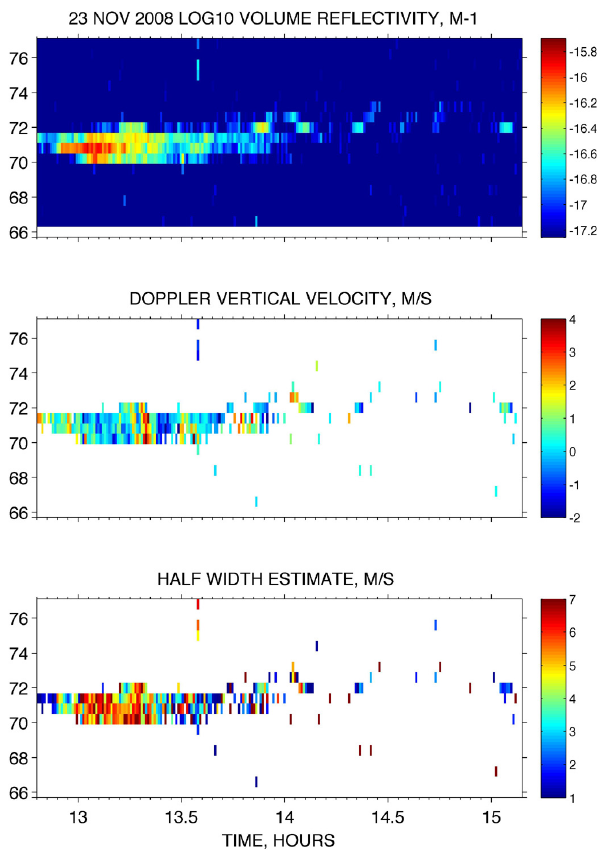
Fig. 1. Log 10 of radar volume reflectivity (upper panel), Doppler vertical velocity (middle panel) and half spectral width (lower panel) for the experiment on 23 November 2008. The vertical axis is altitude in km.